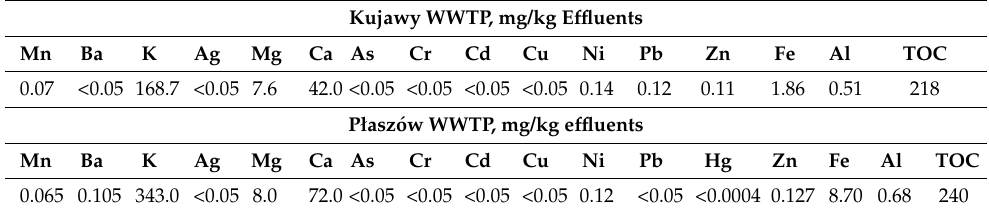
Table 3. Content of metals in digested sludge effluents; arithmetic mean of three measurements.